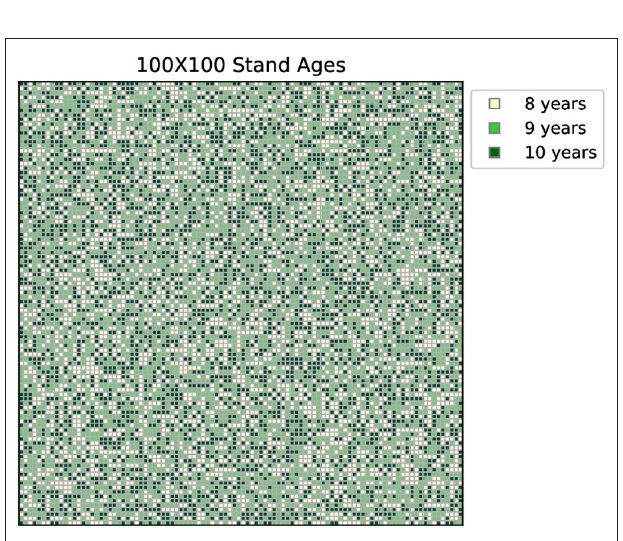
FIGURE 6 | Timber ages for the 10